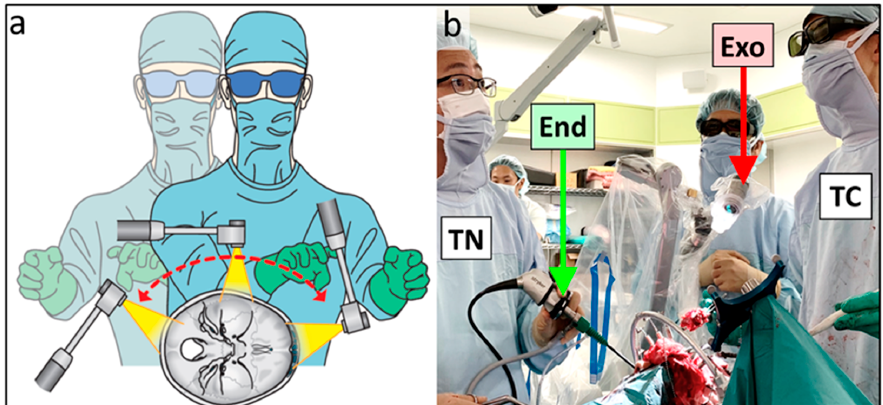
Figure 4. ( a ) Schematic diagram of the surgeon’s posture while using an exoscope. By adjusting the angle of the exoscope and the surgeon’s arms, transcranial procedures can be performed in a comfortable posture, regardless of the angle of the visual axis and patient positioning. ( b ) Intraoperative photograph showing two surgeons simultaneously performing transcranial and transnasal procedures during anterior craniofacial resection. TN: a surgeon performing a transnasal procedure, TC: a surgeon performing a transcranial procedure, End: endoscope, Exo: exoscope.